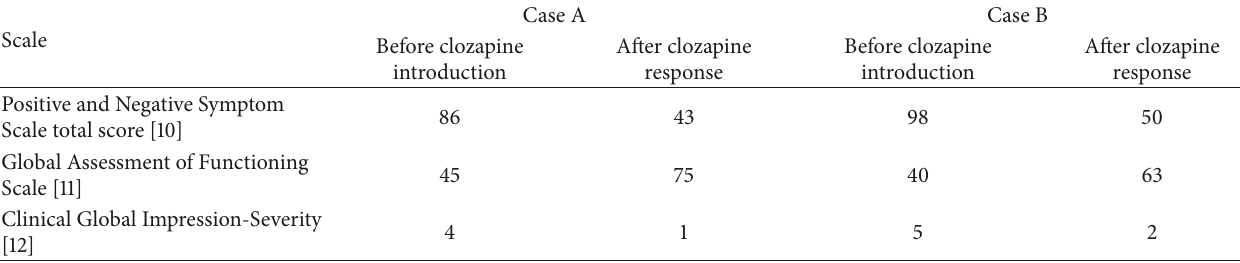
Table 1: Psychopathological, clinical, and functioning assessments before clozapine introduction and after clozapine response. Scale